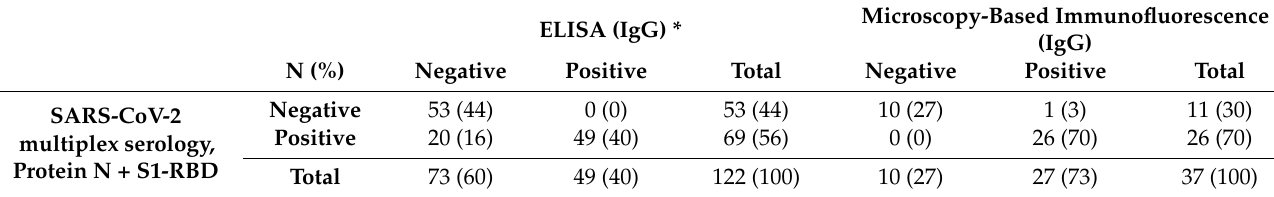
Table 3. Comparison of SARS-CoV-2 sero-positivity in multiplex serology with commercially available ELISA and microscopy-based immunofluorescence detection of antibodies to SARS-CoV-2. Microscopy-Based Immunofluorescence ELISA (IgG) *